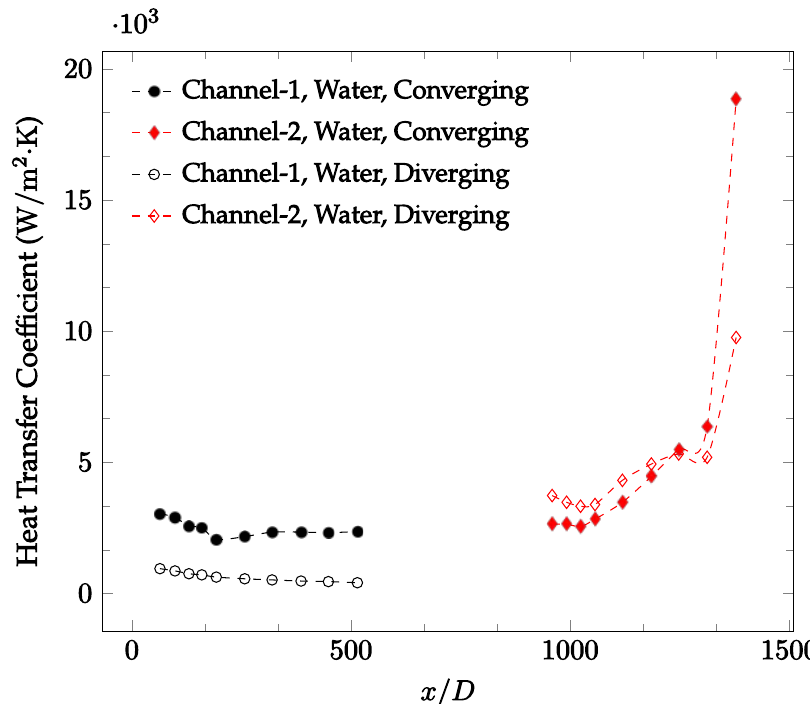
Figure 13. Change in convective heat transfer coefficient of deionized water as a function of dimen- sionless distance for a Reynolds number of 200. Converging and diverging nozzles are used as con- nectors.